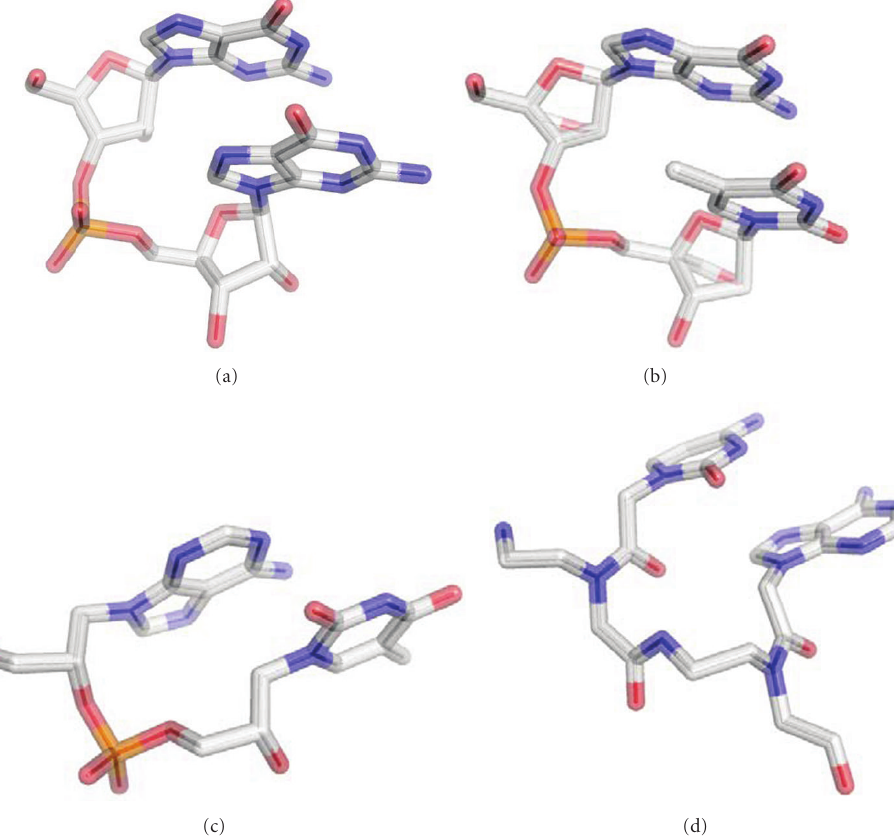
Figure 5: Dinucleotide conformations as observed in RNA (a), LNA with the 2 (cid:2) - O ,4 (cid:2) - C -methylene- β -D-ribofuranose modification (b), GNA (c), and PNA